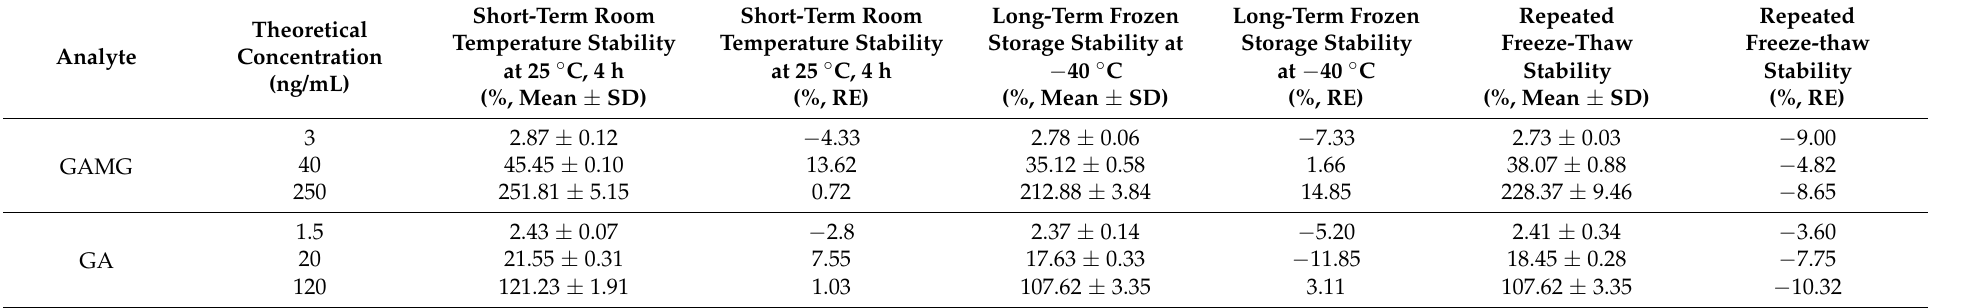
Table 5. The stability of each analyte under different storage conditions ( n =